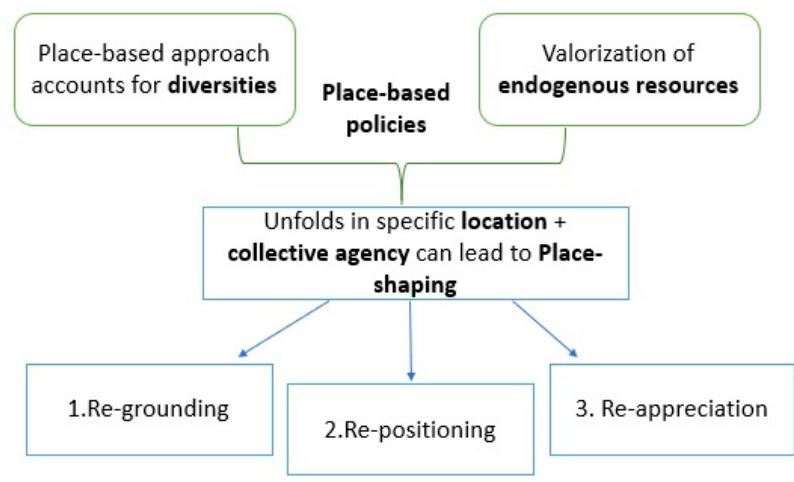
Figure 1. Unfolding of place-based approaches: an analytical framework.